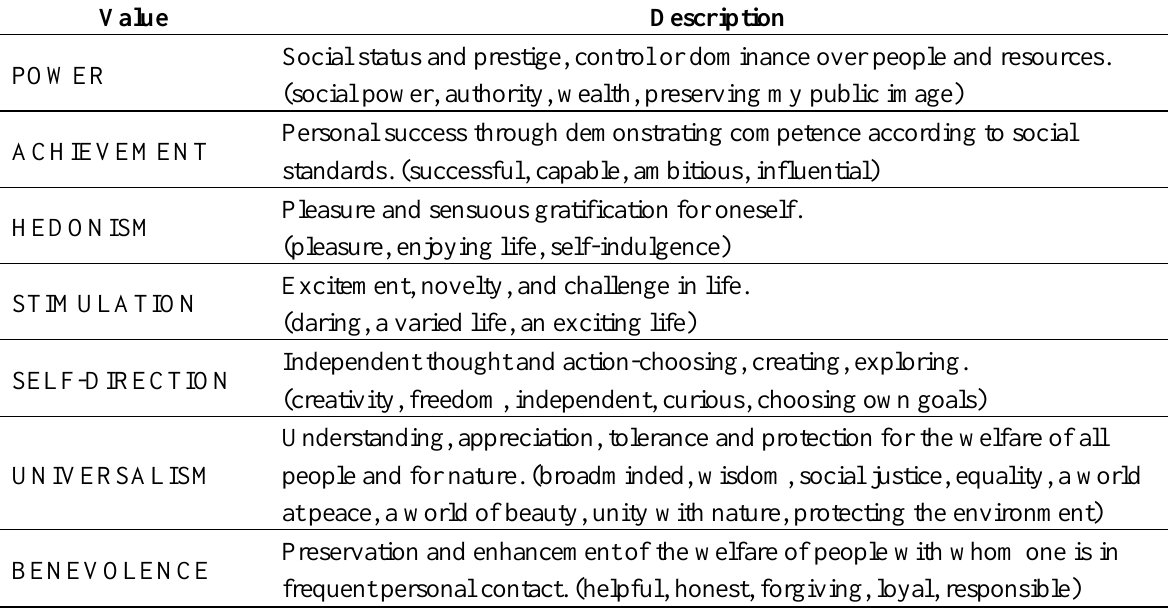
Table 1. The Theory of Universals in Values (TUV) Value Constructs